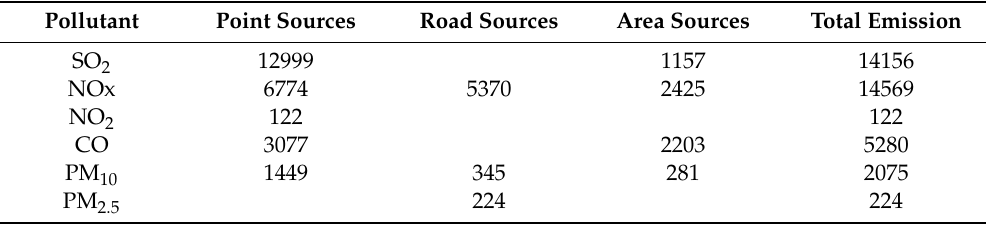
Table 1. Emission of various air pollutants (ton / year) in She ffi eld and surrounding